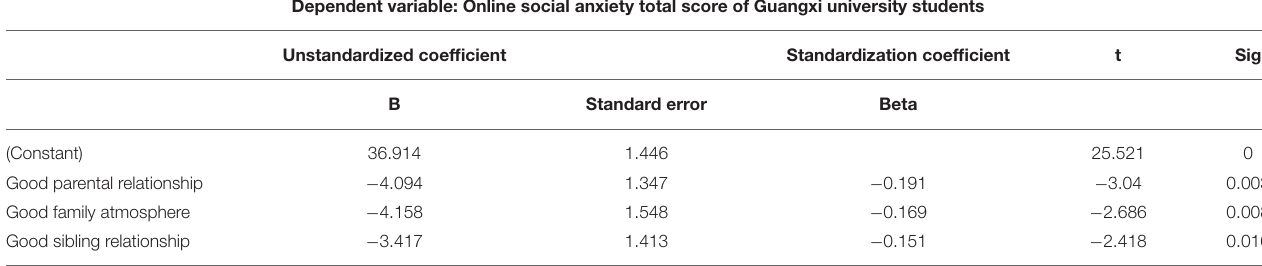
TABLE 2 | Multiple linear regression analysis of online social anxiety ( n =